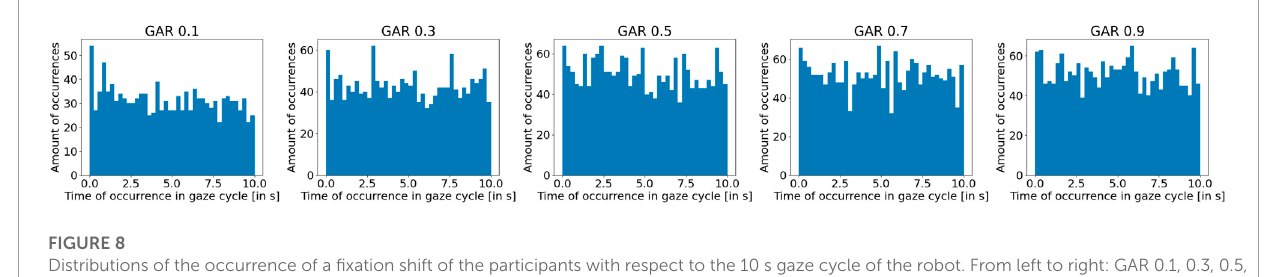
FIGURE 8 Distributions of the occurrence of a fixation shift of the participants with respect to the 10 s gaze cycle of the robot. From left to right: GAR 0.1, 0.3, 0.5, 0.7, 0.9.